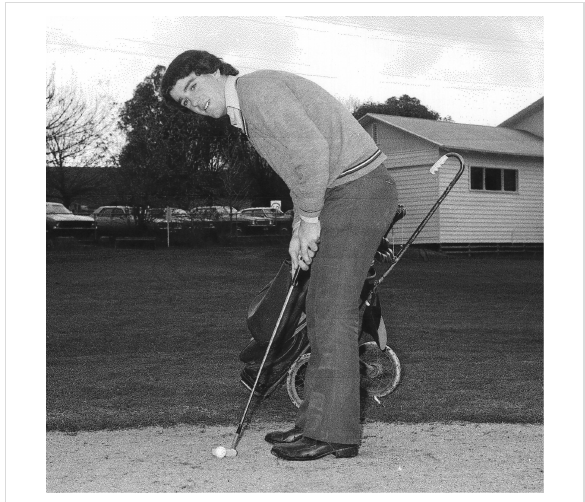
Figure 1: The author as a teenager in his school uniform, but on the nearby Myrtleford golf course.